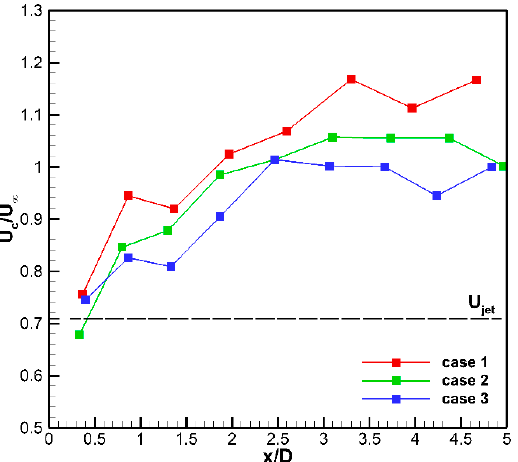
Figure 11. Tracks of windward large-scale structures with the correlation coe ffi cient r s , t .